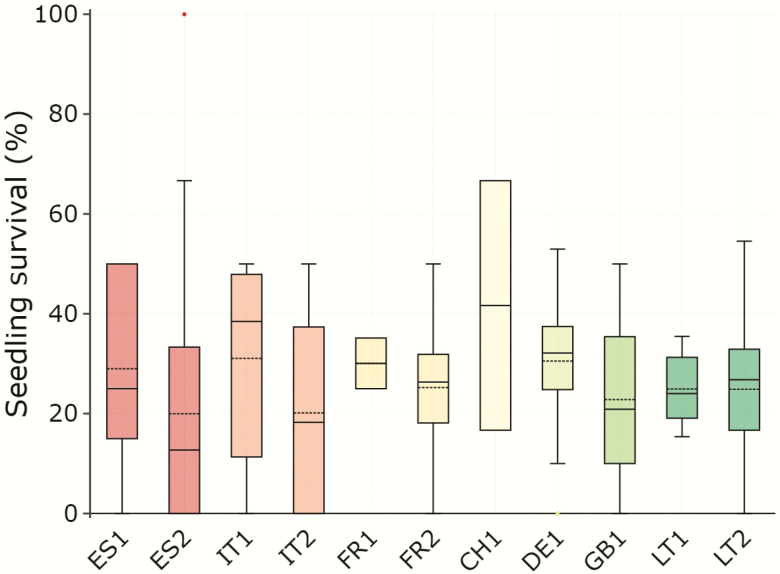
Observed seedling survival rate after the first growing season for Betula pendula populations in a common garden experiment in Germany. Generalized additive models showed differences among populations in ν (P = 0.010) but not in μ (P = 0.171), indicating that populations differed in the estimated proportion of cells without survival (p0), but not in the estimated proportion of cells with at least one seedling alive at the end of the experiment [seeSupporting Information—Table S6]. Boxes show the median (inside solid line), the mean (inside dashed line), the interquartile range (hinges are the 25th and 75th percentiles), 1.5 times the interquartile range (whiskers) and outliers (dots). Population codes as in Table 1. Populations are ordered by latitude, colours as in Fig. 3.